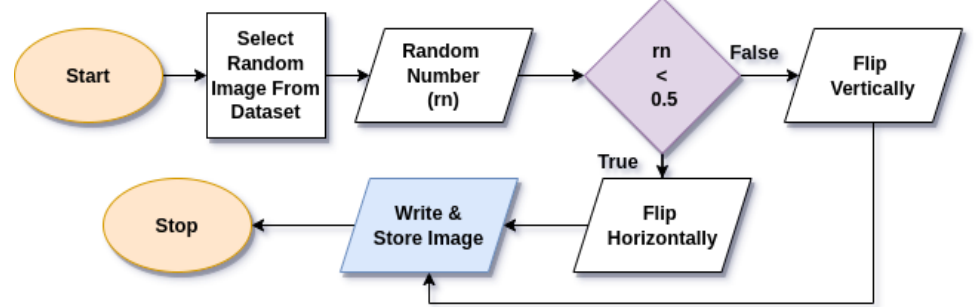
Figure 5. Flow chart for Proposed Methodology.